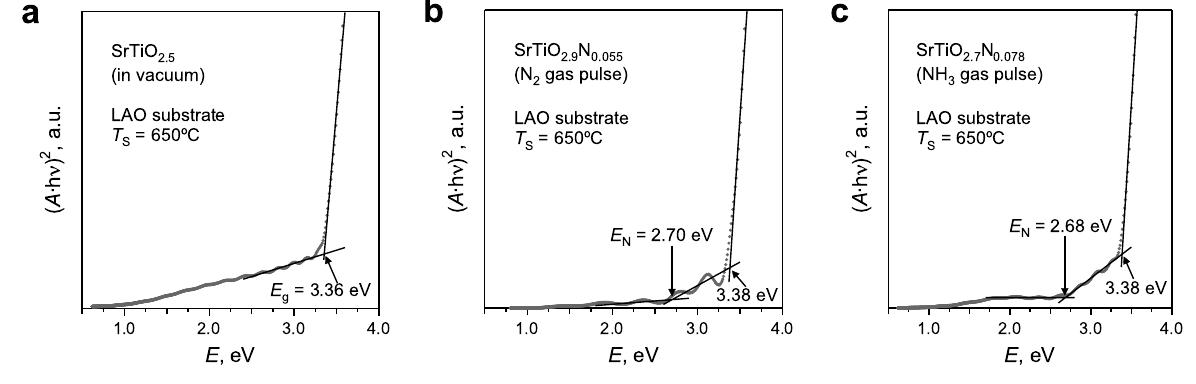
Figure 7. Tauc plots derived from the transmittance spectra of SrTiO (a) in vacuum, (b) with the nitrogen, and (c) with the ammonia gas